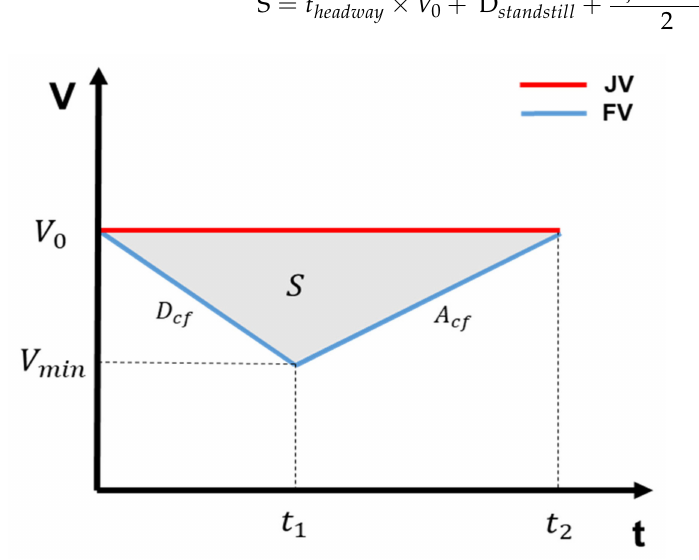
Figure 6. Speed changes of the JV and FV in the opening gap